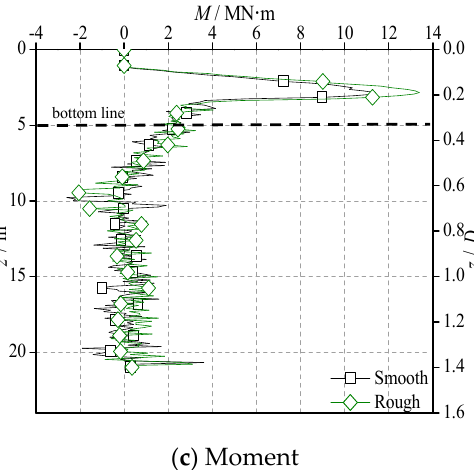
Figure 12. The V , H, and M profile during smooth and rough conditions. (TB − 2 D − 0.25 D ).